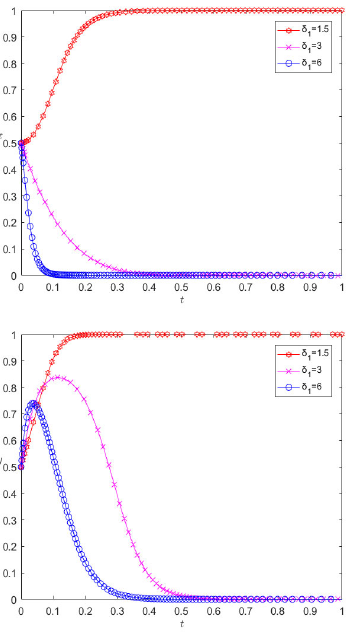
Figure 7. Evolution results of changing excitation parameters.